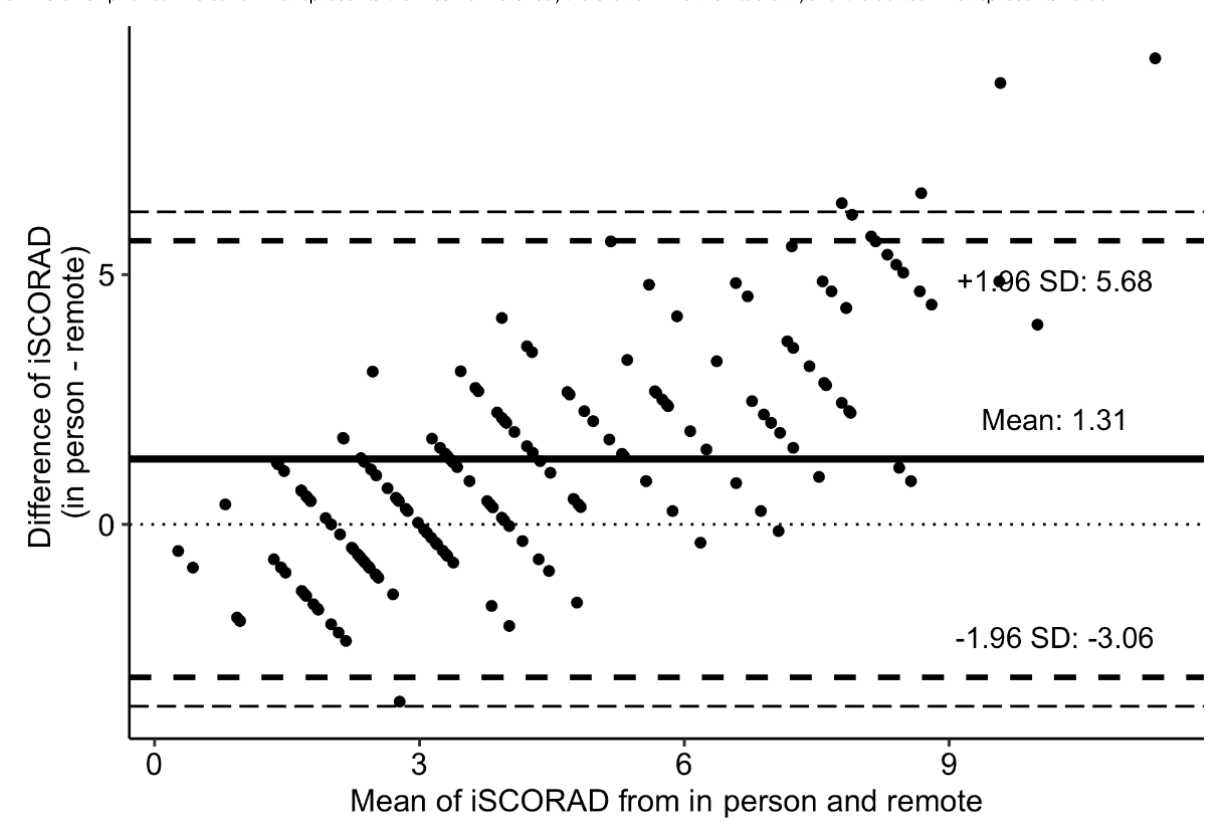
Figure 2. A Bland-Altman plot analyzing the difference between the intensity items of Scoring AD (iSCORAD) assessed in person and from photographs taken via smartphone. The solid line represents the mean difference, the broken line the 1.96 SD, and the dotted line represents zero.